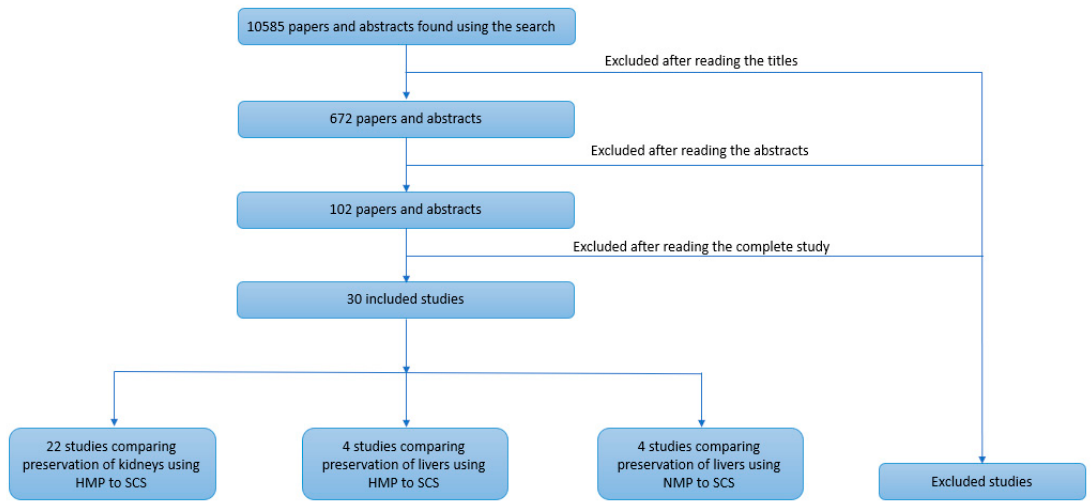
Figure 1. Flow diagram of the systematic literature search.